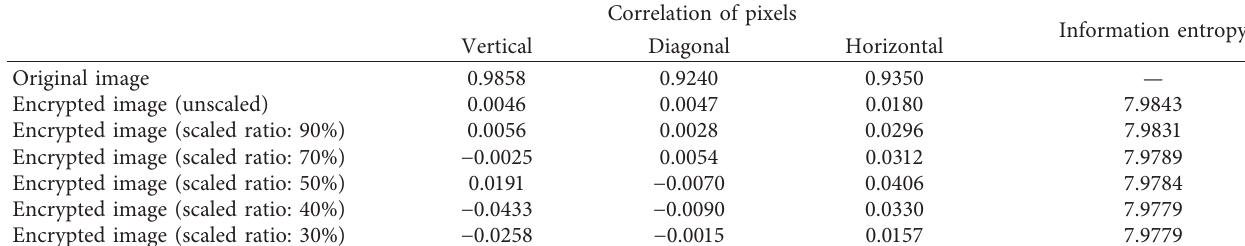
Table 2: Evaluation of encryption effect.